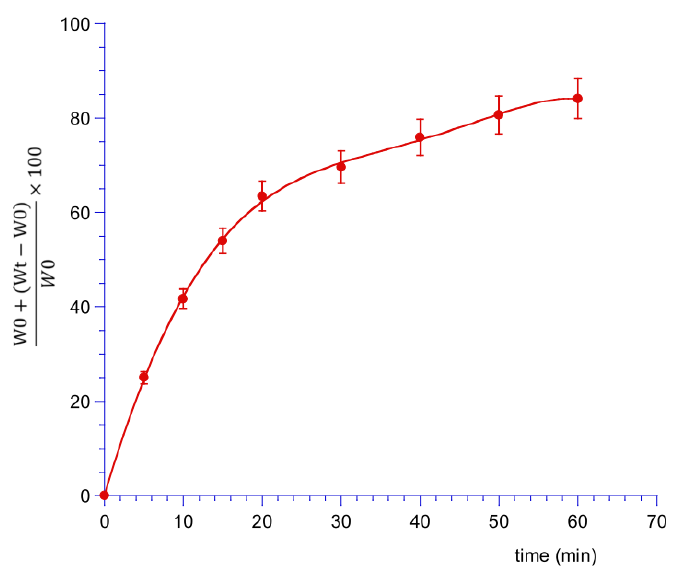
Figure 3. Swelling index measured as percent of weight increased vs. time. Values are presented as means ± SE ( n = 9).